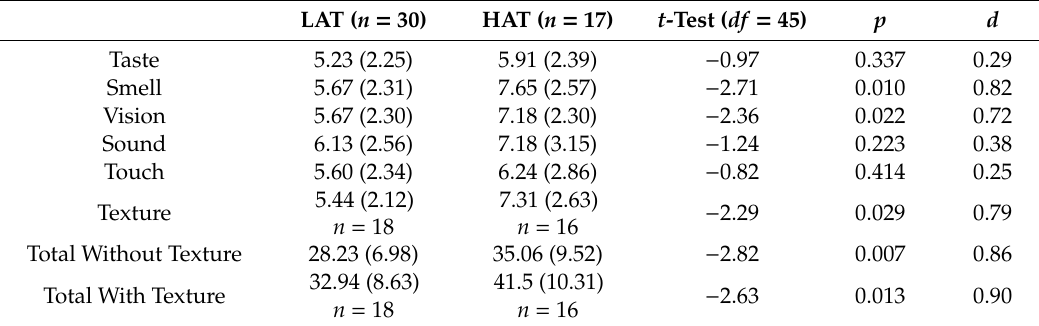
Table 2. Summary of group di ff erences on sensory screening